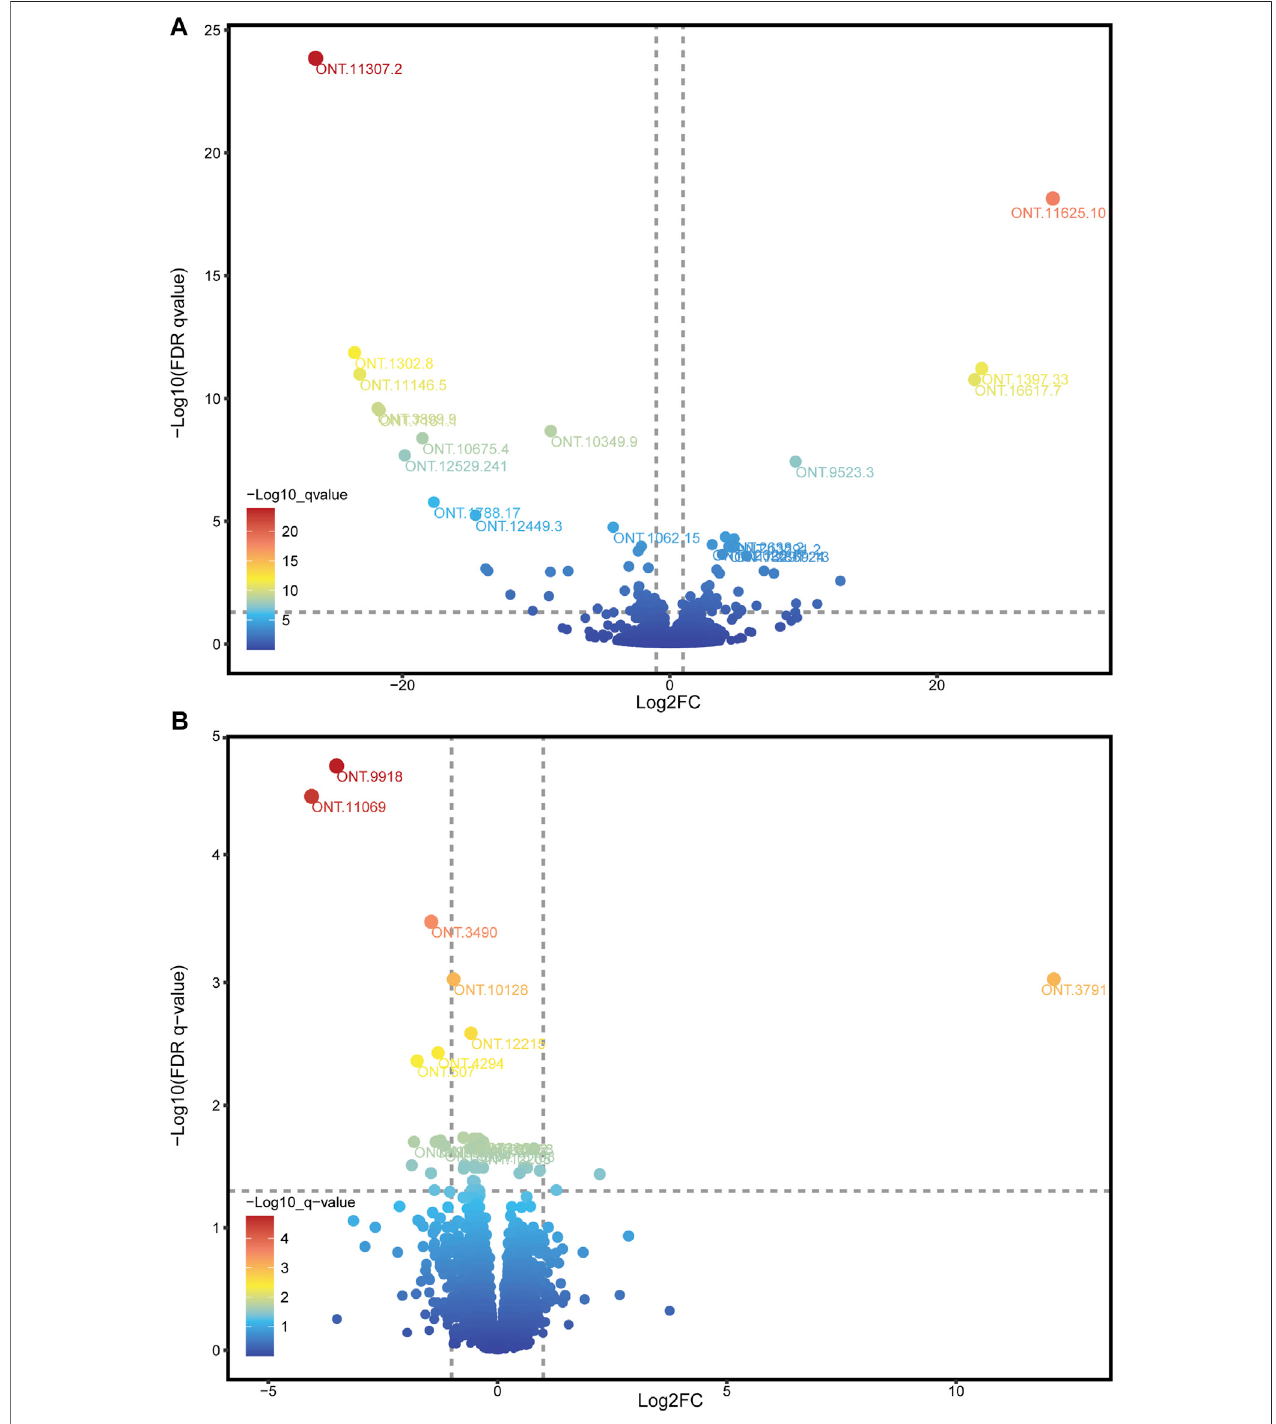
FIGURE 4 | Volcano plot of DESIs and DEGs. (A) Volcano plot of DESIs, showing the top 20 splicing isoforms ID with the smallest q-values; (B) Volcano plot of DEGs, showing the top 15 genes ID with the smallest q-values.